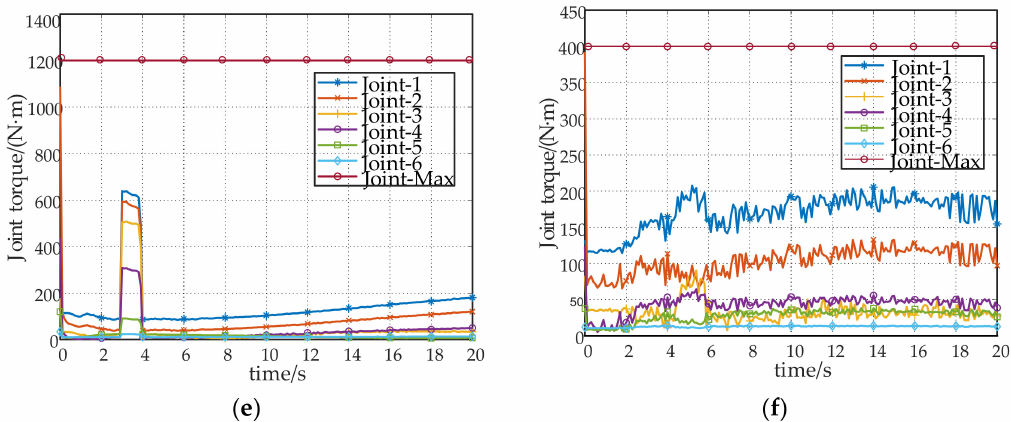
Figure 14. The parameters changes of the robot during obstacle avoidance. Graphs in ( a , c , e ) represent the parameter changes (joint angle, joint angular velocity, and torque) of the right robotic manipulator during obstacle avoidance. Graphs in ( b , d , f ) represent the parameter changes (joint angle, joint angular velocity, and torque) of the left robotic manipulator during obstacle